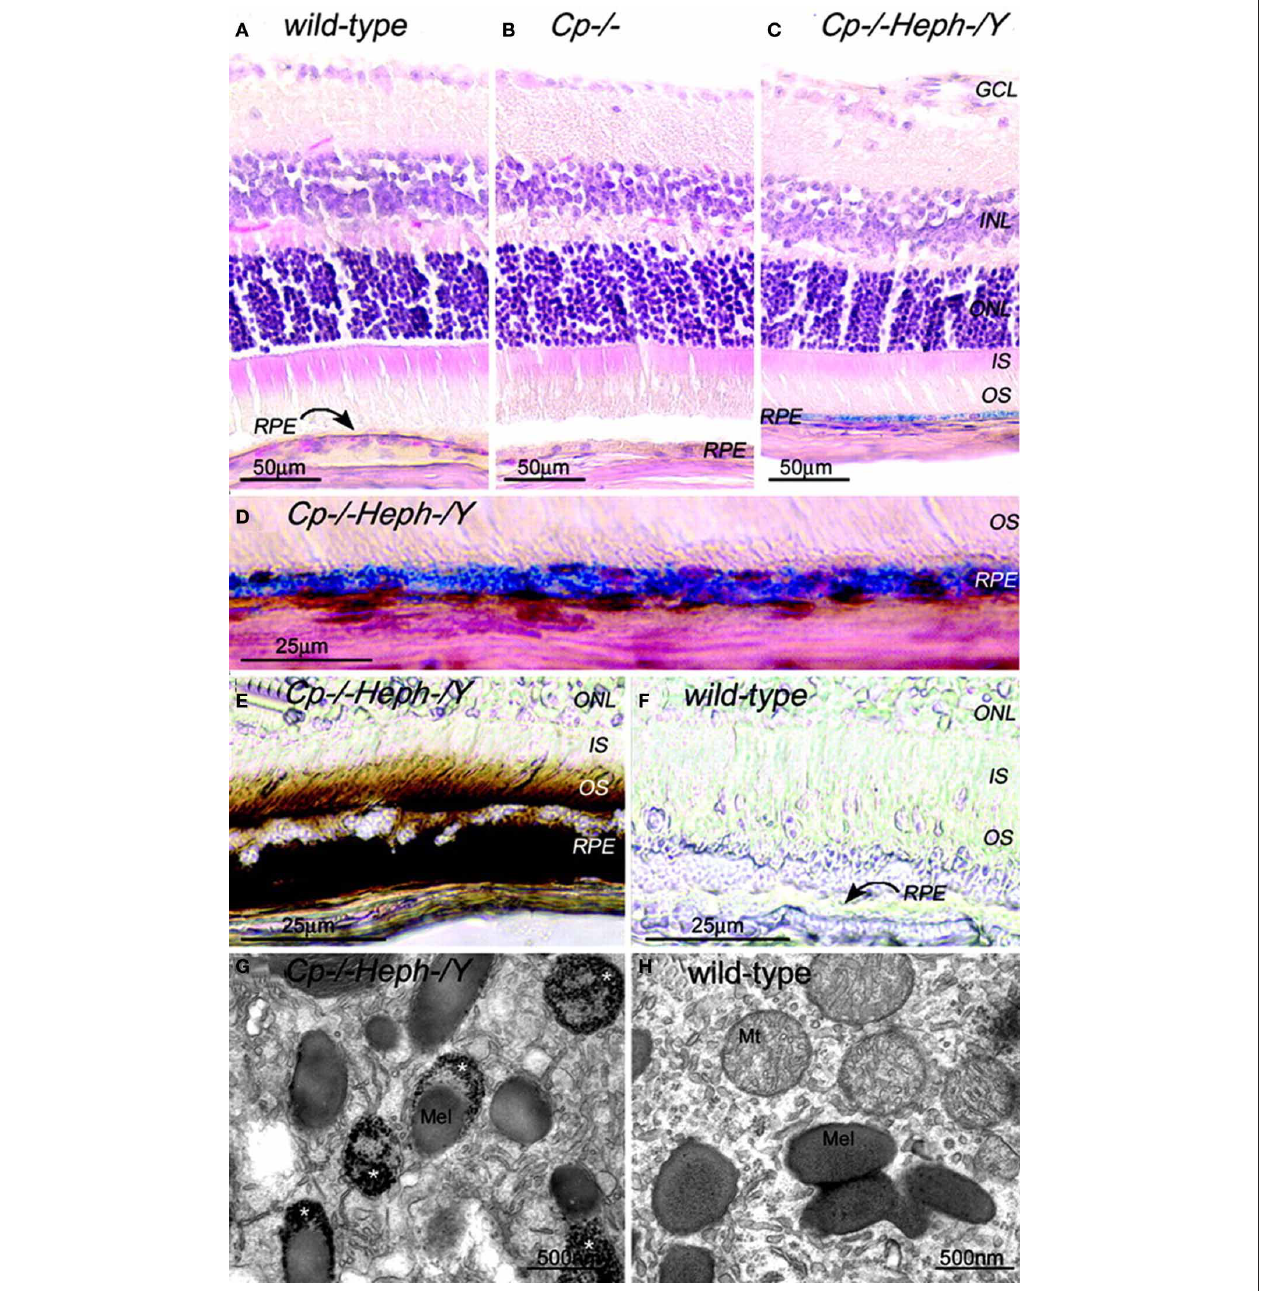
6-month-old Cp − / − Heph − /Y (E) and WT (F) retinas after DAB enhancement (brown) of Perls’ stain. ( G and H ) Electron micrographs of RPE from 6-month-old Cp − / − Heph − /Y (G) and WT (H) eyes. Only the Cp − / − Heph − /Y RPE (G) contains electrondense vesicles ( ∗ ) sometimes fused with melanosomes. Reprinted from Hahn et al.